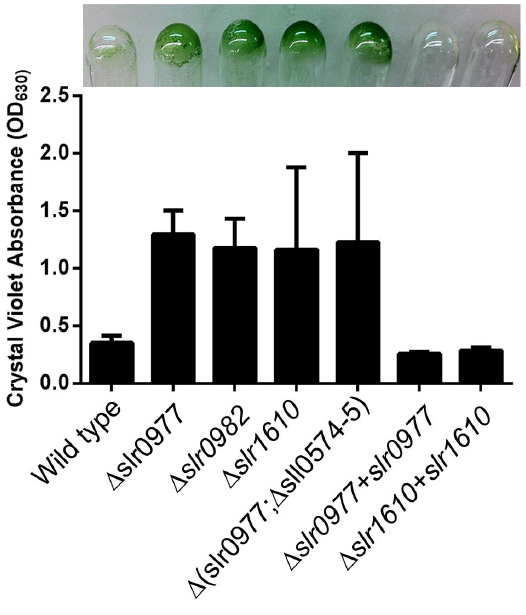
Figure 2. Adherence of Synechocysis mutants to glass culture vessels. Quantification was carried out by spectrophotometry of crystal violet staining of attached cells. Strains were grown statically in 2 mL of BG-11 at 30 u C with 40 m mol photons m 2 1 s 2 1 for 4 days. Data are the combination of at least three biological replicates. Represen- tative data of strains adhering to glass culture vessels (inset). Error bars indicate the standard deviation from the mean.